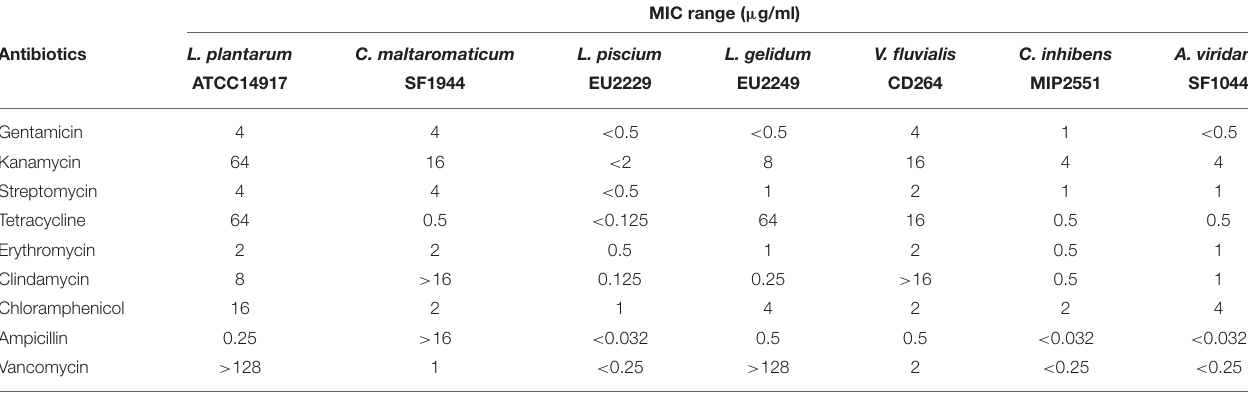
TABLE 5 | Protective cultures susceptibility toward nine